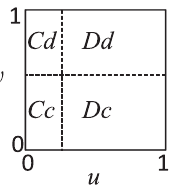
Figure 3. The average fractions over u { v parameter plane of Cc , Cd , Dc , Dd in dependence on p . For each p , the simulations run on 51 | 51 square lattice with ( u , v ) in discrete u { v parameter plane. The initial average fractions of the four types are all 0 : 25 .